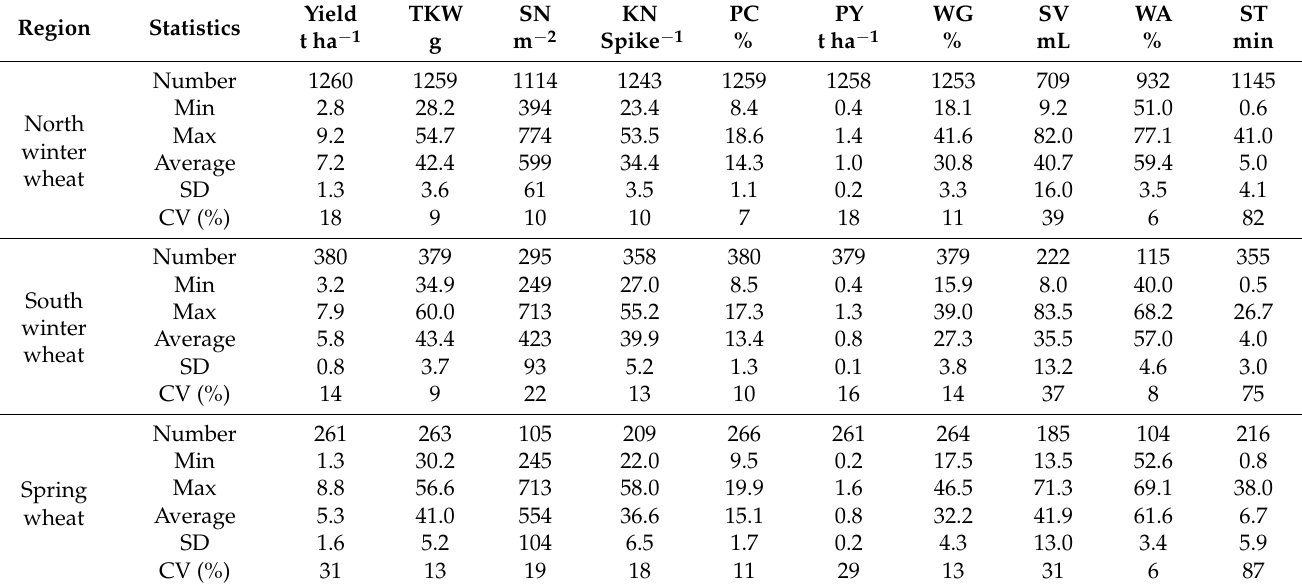
Table 1. Statistics of wheat yield and quality parameters for the three wheat-growing